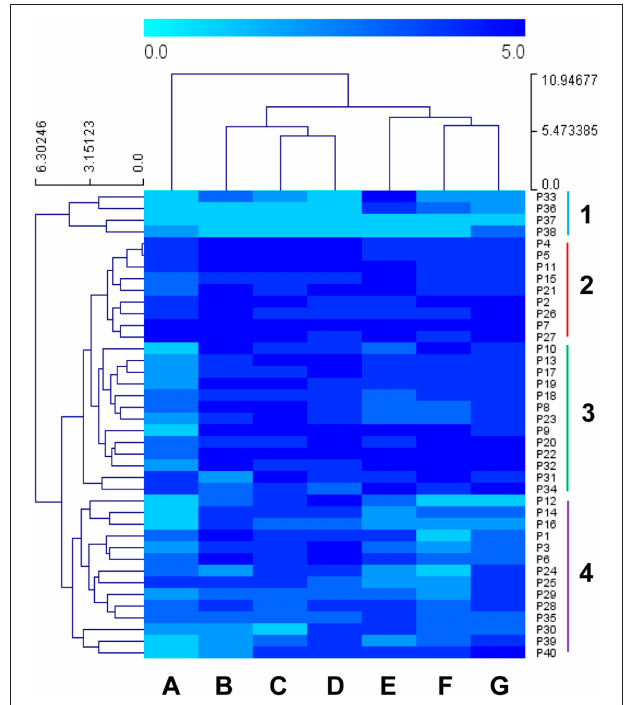
FIGURE 1 | Heatmap illustrating the area under the curve (AUC) of 40 strains under seven different conditions. Growth experiments were performed in synthetic must (SM) at 12 and 15 ◦ C for the low temperature analysis and SM at 28 ◦ C after oxidative shock to test the recovery capability. In order to normalize the different conditions, strains were divided into five groups depending on the minimum and maximum AUC value of the population per experiment. (A) Cumene hydroperoxide 0.5 mM at 28 ◦ C, (B) SM at 15 ◦ C, (C) SM at 12 ◦ C, (D) Hydrogen peroxide 4 mM at 28 ◦ C, (E) SM at 28 ◦ C, (F) Menadione 2 mM at 28 ◦ C, (G) Tert butyl hydroperoxide at 28 ◦ C. Sensitivity is indicated in light blue, and resistance in dark blue. The four groups separated by the Hierarchical clustering analysis (HCL) are marked by